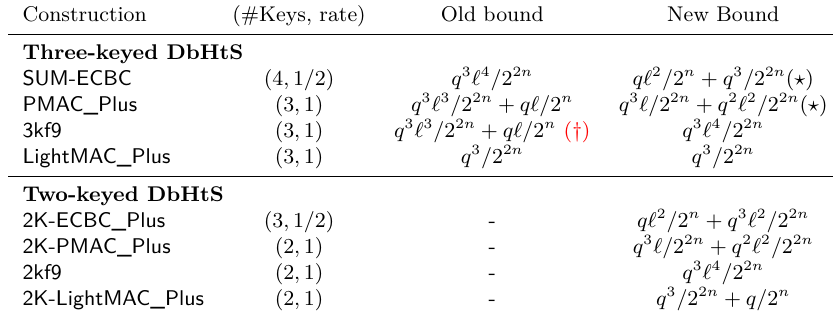
Table 1: #Keys denote the number of block cipher keys used in the construction. Rate defines the average number of message blocks processed by a single execution of block cipher. q denotes the total number of queries and ‘ denotes the maximum number of message blocks in all q queries. Only the dominant terms of the security bounds are